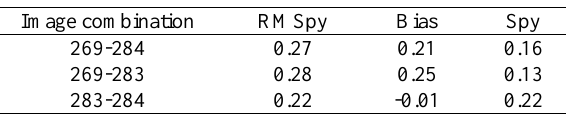
Table 9. y-parallaxes of intersection based on LSM